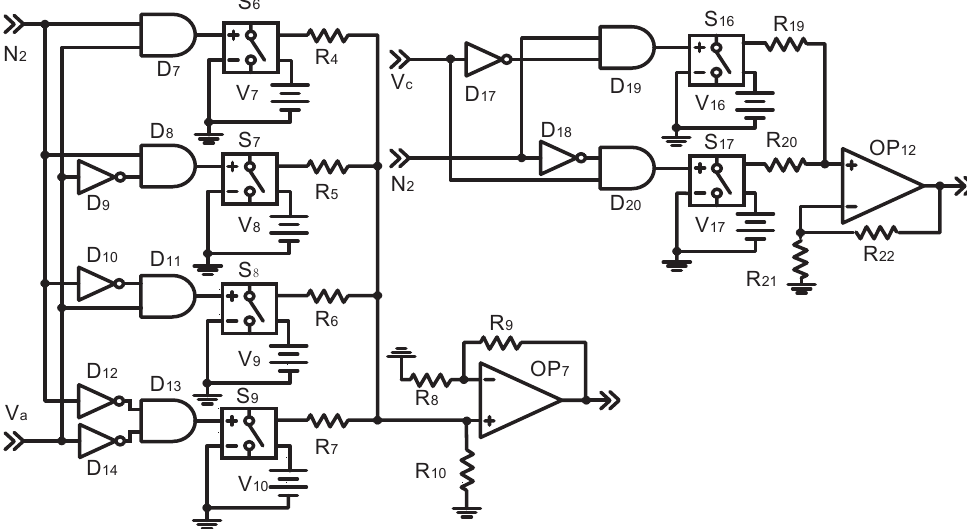
Figure 7. Emotion module. V 7 = − 0.5 V, V 8 = 0.01 V, V 9 = 0.5 V, V 10 = − 0.01 V, V 16 = − 0.2 V, V 17 = 0.2 V. R 4 = R 5 = R 6 = R 7 = R 9 = R 10 = R 19 = R 20 = R 21 = R 22 = 20 k Ω , R 8 = 5 k Ω . D 7 is a AND gate to control S 6 . D 8 and D 9 control S 7 . D 10 and D 11 control S 8 . D 12 , D 13 and D 14 control S 9 . D 17 and D 19 control S 16 . D 18 and D 20 control S 17 . OP 12 , R 19 , R 20 , R 21 , R 22 form a voltage summation unit. OP 7 , R 4 , R 5 , R 6 , R 7 , R 8 , R 9 and R 10 form a voltage summation